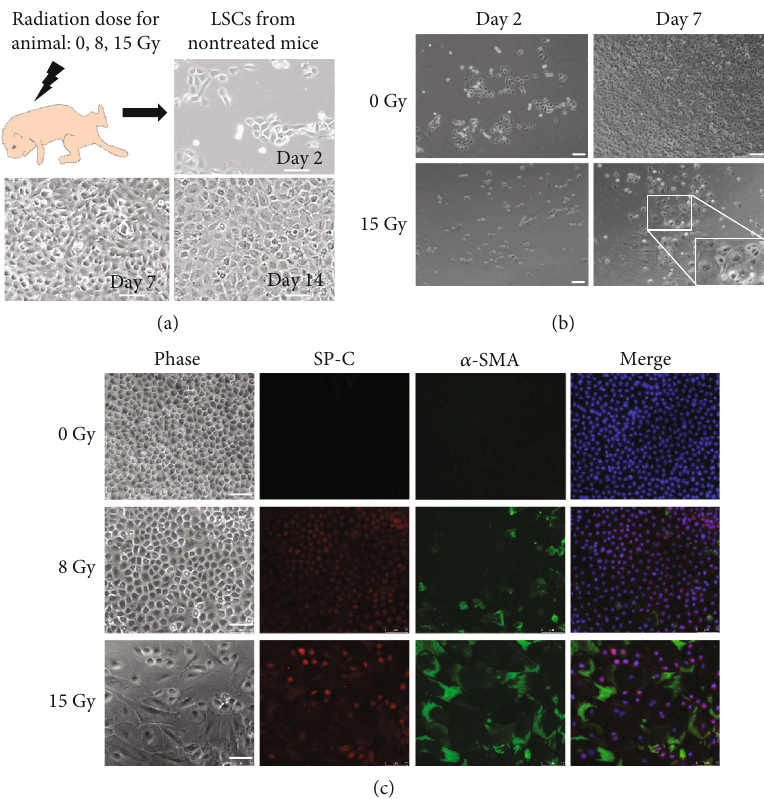
Figure 3: The fi brogenic di ff erentiation of LSCs from irradiated mice. (a) Work fl ow of ex vivo lung cell irradiation experiments. The cell growth and di ff erentiation of LSCs isolated from irradiated neonatal mice were analyzed following incubation for 14 days and compared with those isolated from nontreated mice. Scale bars, 100 μ m. (b) LSCs were isolated from control neonatal mice or mice exposed to the indicated dosage of radiation. Cell morphology and density were examined after seeding 1 × 10 5 isolated LSCs within 5 days. Scale bars, 100 μ m. (c) The populations of α -SMA + (green) and SP-C + (red) cells were costained in isolated LSCs and were analyzed, followed by incubation for 14 days. The nuclei of cells were stained blue with DAPI. Scale bars, 70 μ